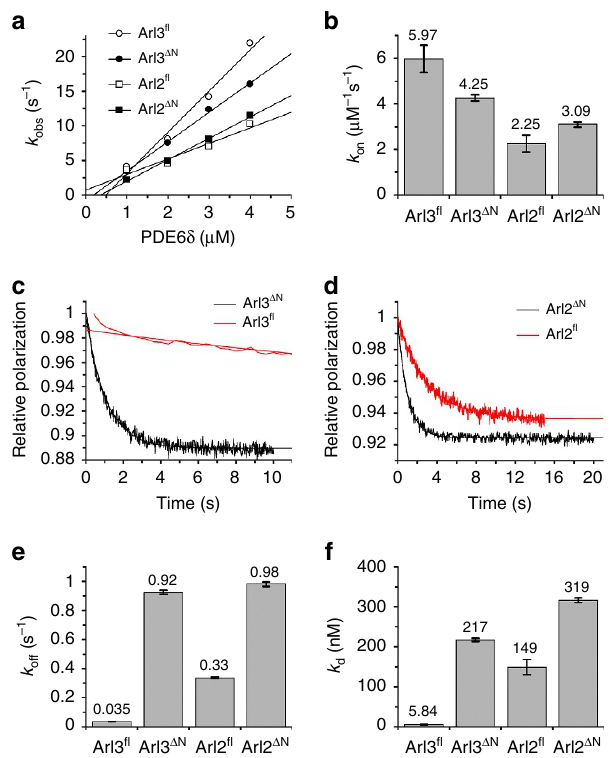
Figure 3 | Contribution of the N-terminal helix of Arl3 to the binding affinity with PDE6 d . ( a ) Stopped-flow fluorescence polarization kinetic measurements of the association of 0.2 m M mantGppNHp loaded Arl proteins with increasing concentrations of PDE6 d . The observed pseudo- first order rate constants ( k obs ) are plotted against PDE6 d concentration. ( b ) Bar charts of the association rate constants ( k on ) determined in a . ( c , d ) Stopped-flow fluorescence polarization kinetic experiments where complexes of 2 m M PDE6 d with 0.2 m M of full-length (Arl fl ) or N-terminally deleted (Arl D N ) mantGppNHp loaded Arl proteins as indicated were mixed with 200-fold excess of unlabelled Arl proteins to determine k off . ( e ) Bar charts of the dissociation rate constants ( k off ) from experiments in c , d . ( f ) Bar charts of the equilibrium dissociation constants ( K d ) of complexes between PDE6 d and Arl proteins as determined from the kinetic constants in c , e . Error bars indicate s.d., n ¼